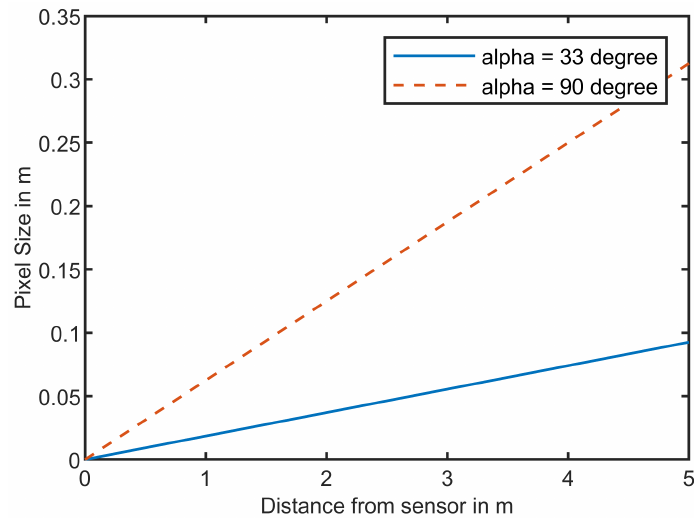
Figure 6. Size of pixel in different distances from the